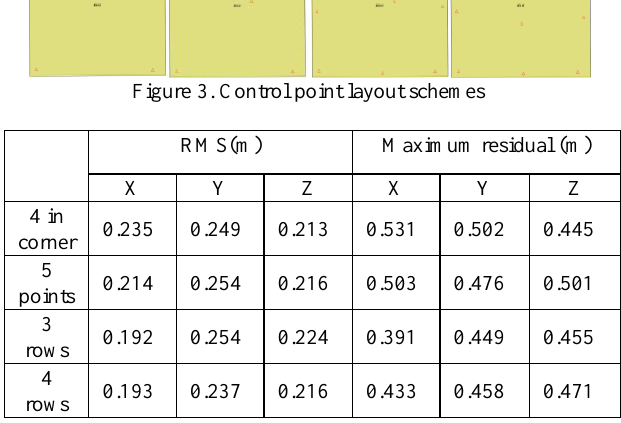
Table 1. Accuracy of different control point